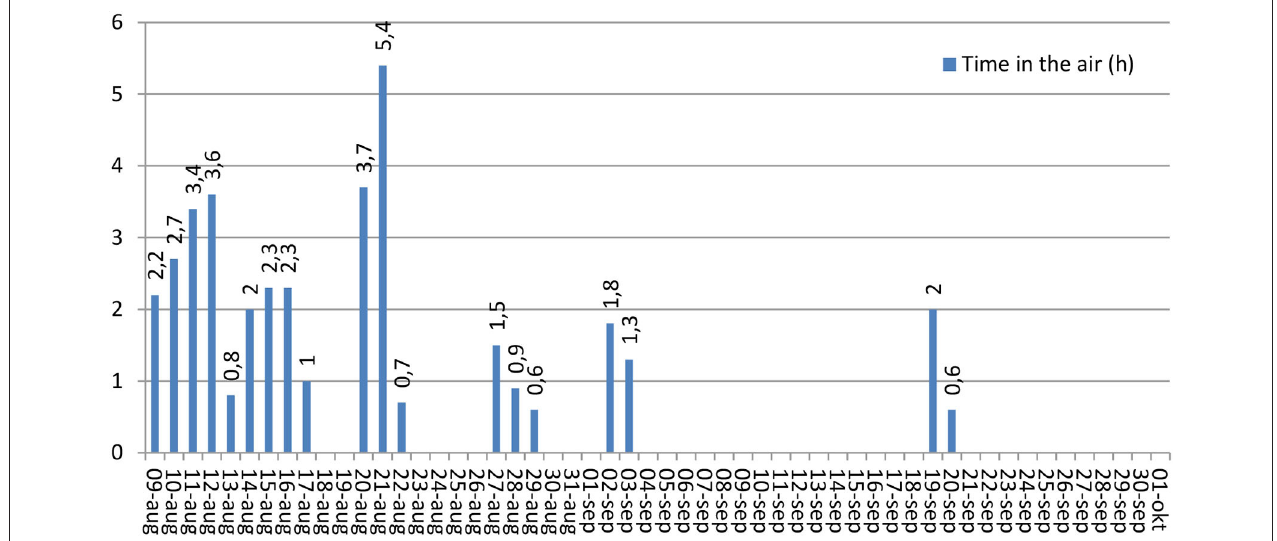
FIGURE A1 | Dosage of helicopter per day, measured as time spent in the air for the